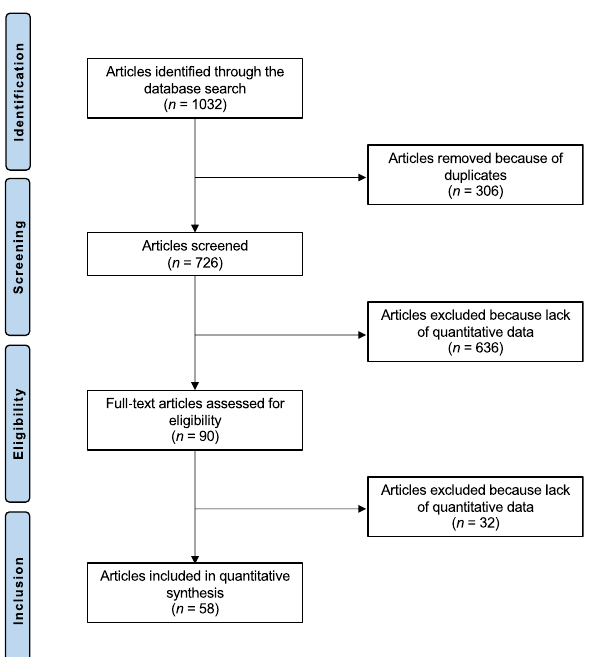
Figure 1. Flow chart of the literature